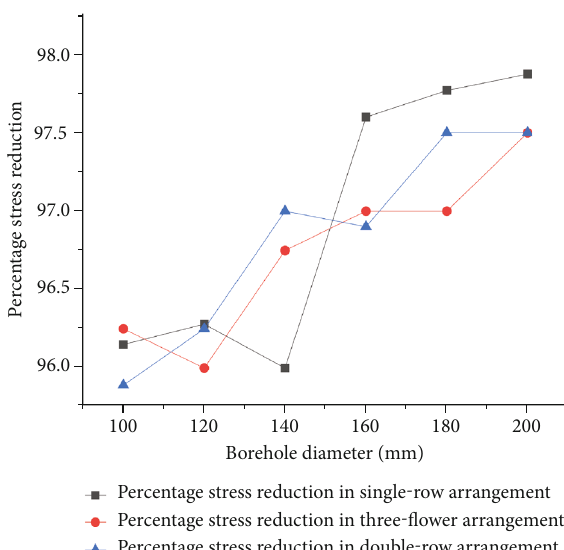
Figure 12: Stress reduction degree in boreholes of di ff erent diameter.